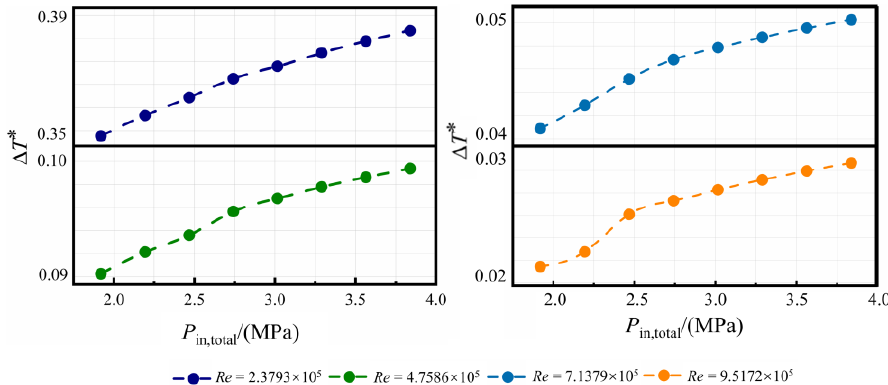
Figure 18. Distribution of ∆ T * at different Re .